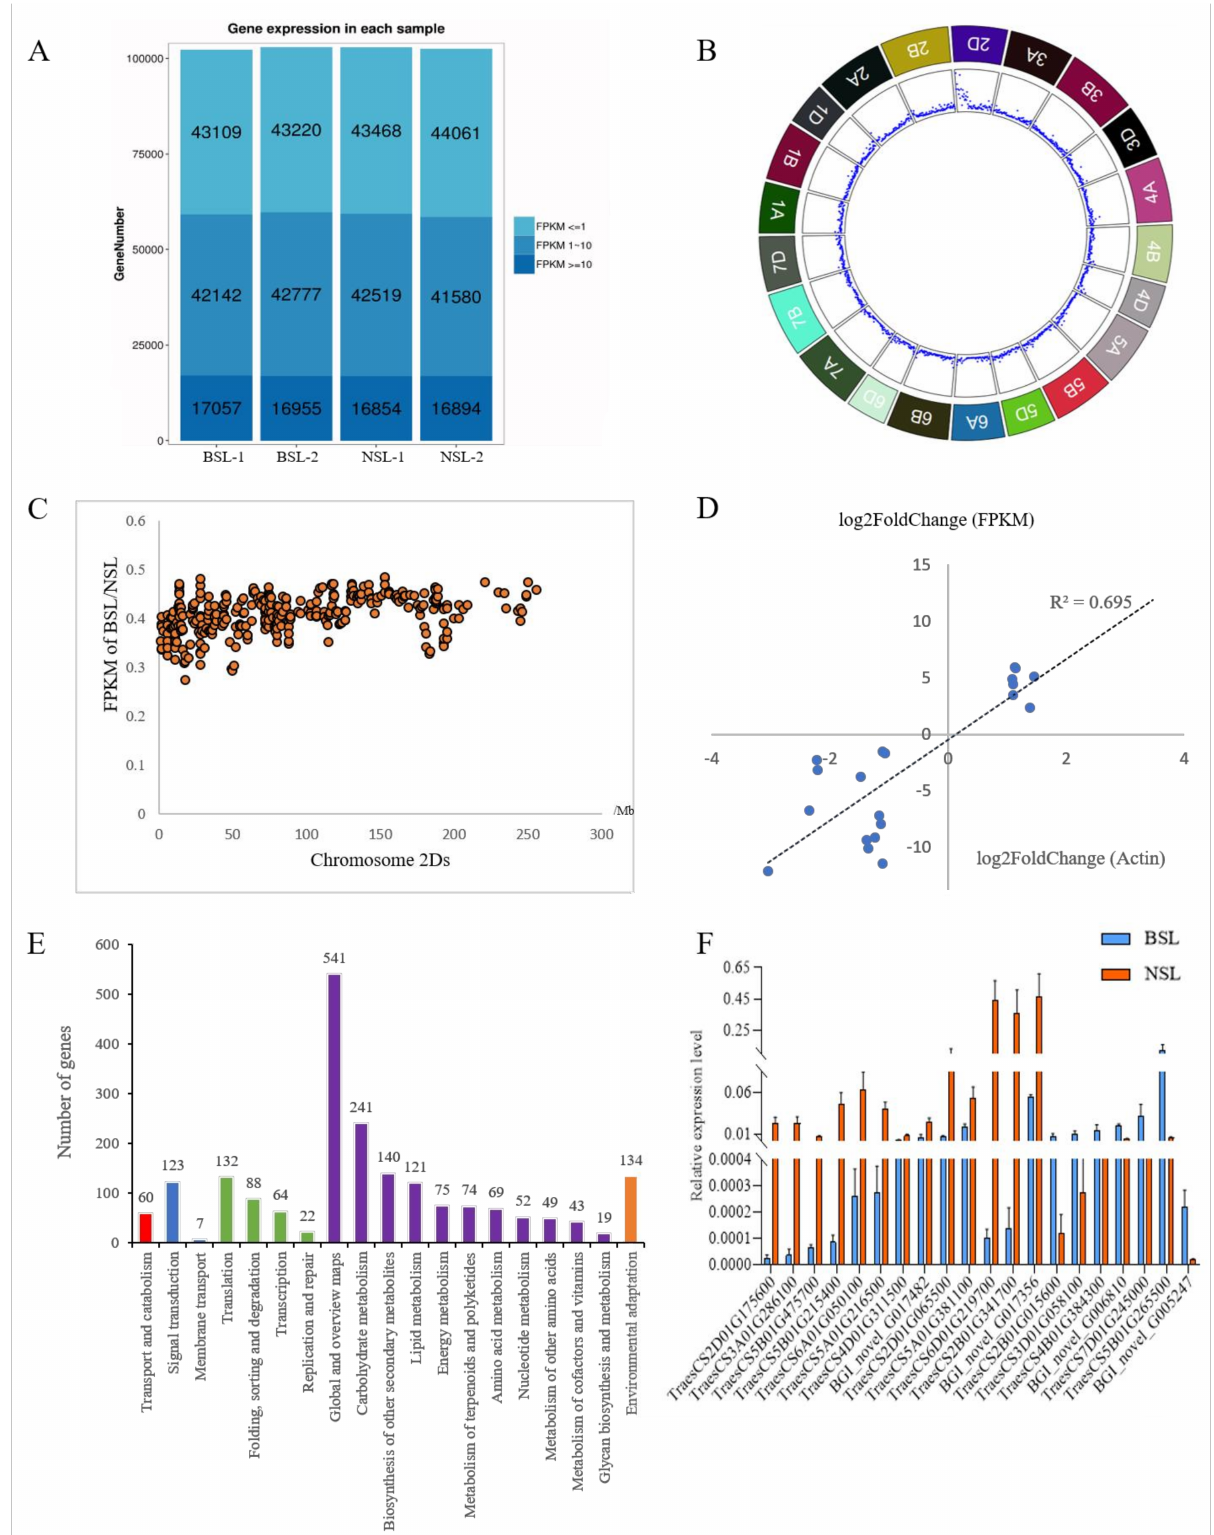
Figure 2. Analysis of DEGs expressions. ( A ) Levels of the expressions of all the genes detected in transcriptome sequencing of the BSL and the NSL bulks. ( B ) The density of DEGs on wheat chromosomes. ( C ) DEGs on 2Ds chromosome. Each dot represents the ratio of FPKM of a gene in the BSL plants when compared to the NSL plants. ( D ) Significant correlations between RNA-seq and qRT-PCR with Actin as a reference. ( E ) KEGG analysis of DEGs in the BSL and the NSL bulks. ( F ) Verification of 20 key transcripts in the representative pathways by